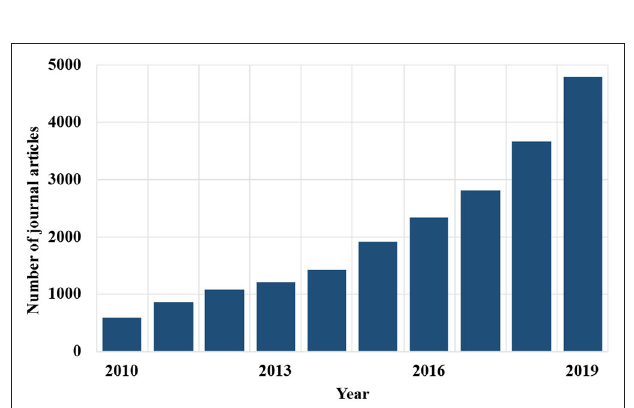
FIGURE 5 | Chronological literature researches on MOFs, keywords, metal organic frameworks, and MOFs (retrieved from Scopus).